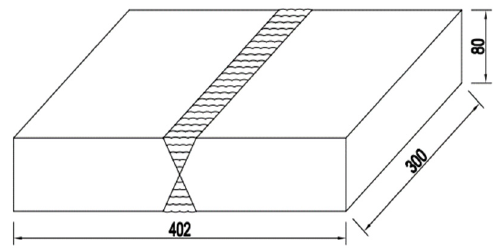
Figure 2. Dimension of steel plate (unit mm).